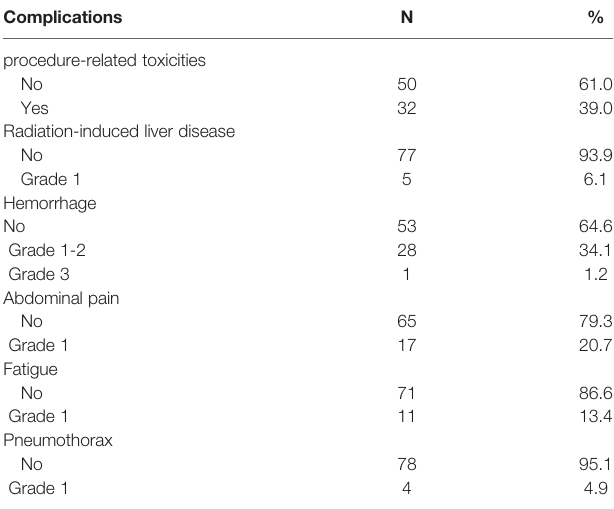
TABLE 2 | Complications experienced by the patients following